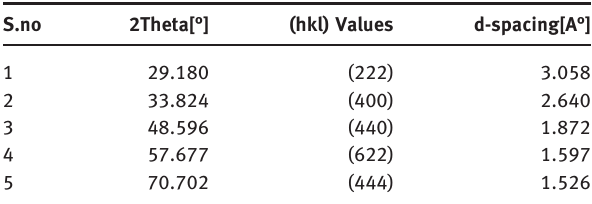
Table 3: Parameters of Ce 2 Zr 2 O 8 powders calculated from XRD